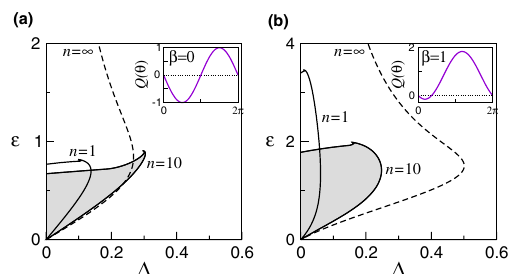
FIG. 2 (color online). Synchronization boundaries for PRCs with σ ¼ sin β , where (a) β ¼ 0 and (b) β ¼ 1 , and for pulselike interactions (3) with n ¼ 1 , 10, and ∞ (Dirac ’ s delta). Insets: PRCs Q ð θ Þ , see Eq. (2). The region of synchronization for n ¼ 10 appears